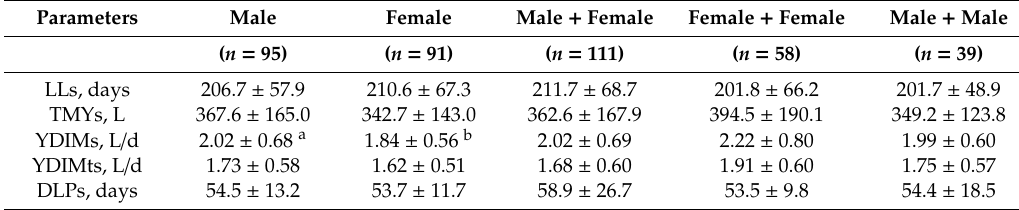
Table 6. Productivity parameters in mature ewes and maiden sheep with male and / or female o ff spring during the lactation after having lambed those